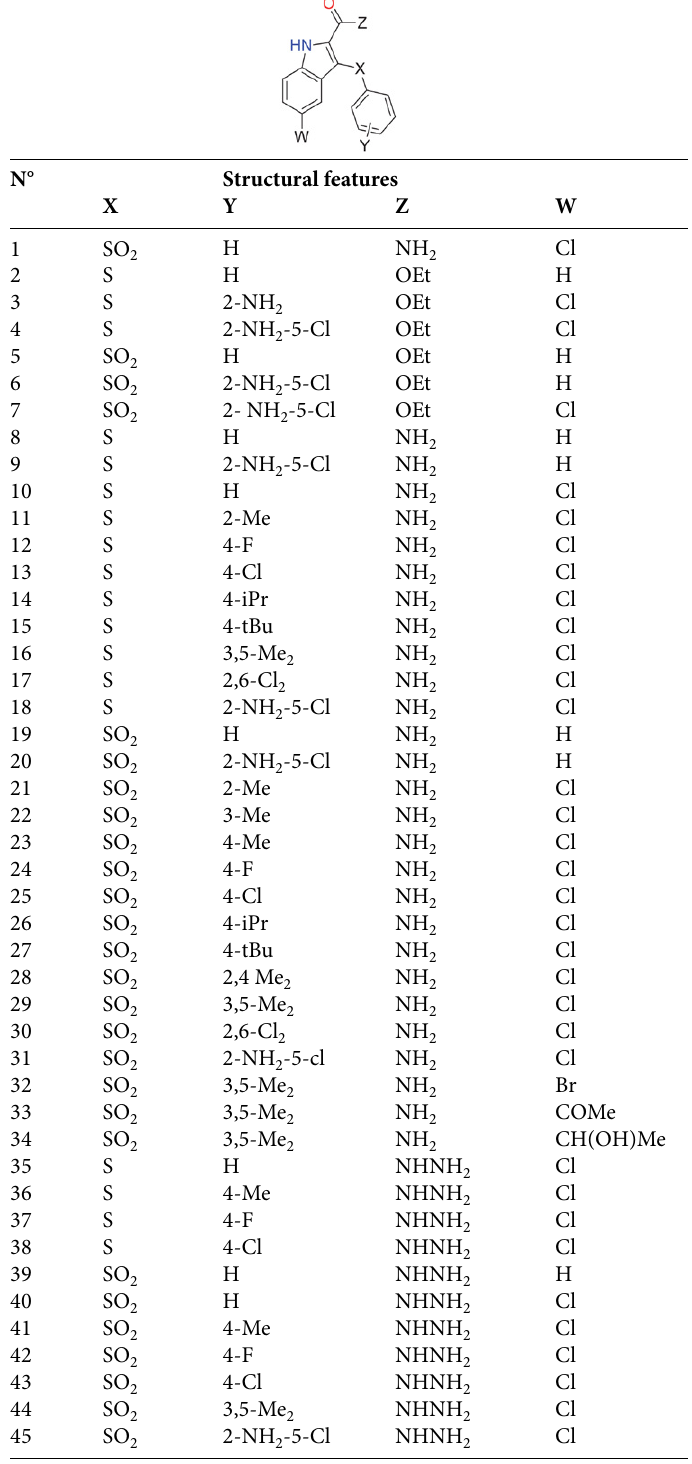
Table 1. Various substituents attached to basic structure of indolyl-aryl-sulfones.